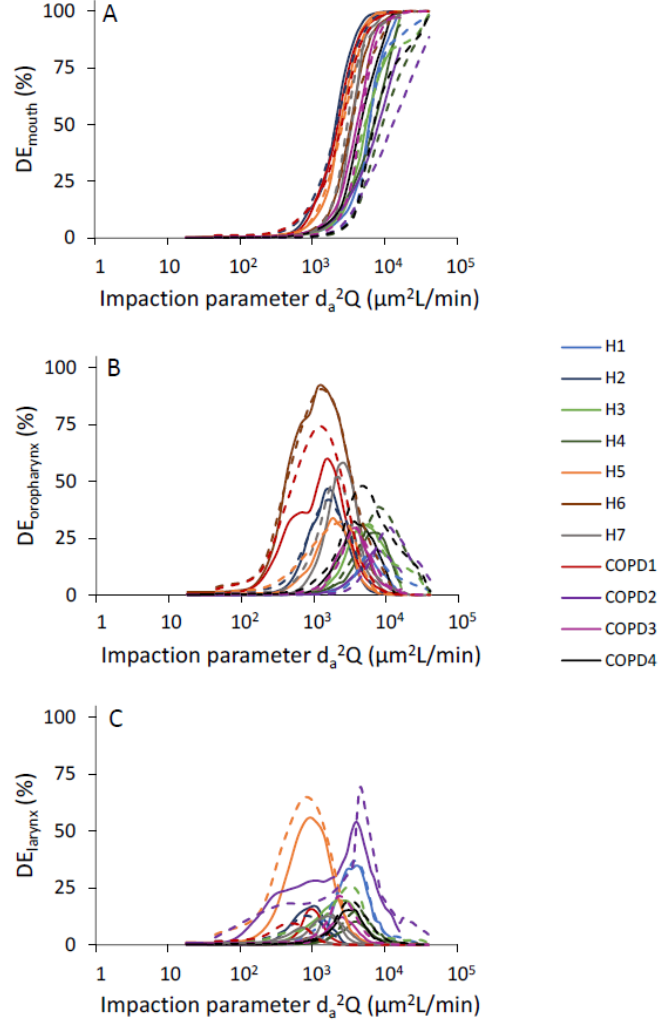
Figure 3. Inspiratory regional deposition (DE) vs. inertial impaction parameter. Solid and dashed lines represent deposition fraction at inhalation flow rate of 18 (L/min) and 45 (L/min), respectively. ( A ): Mouth. ( B ): Oropharynx. ( C ): Larynx.